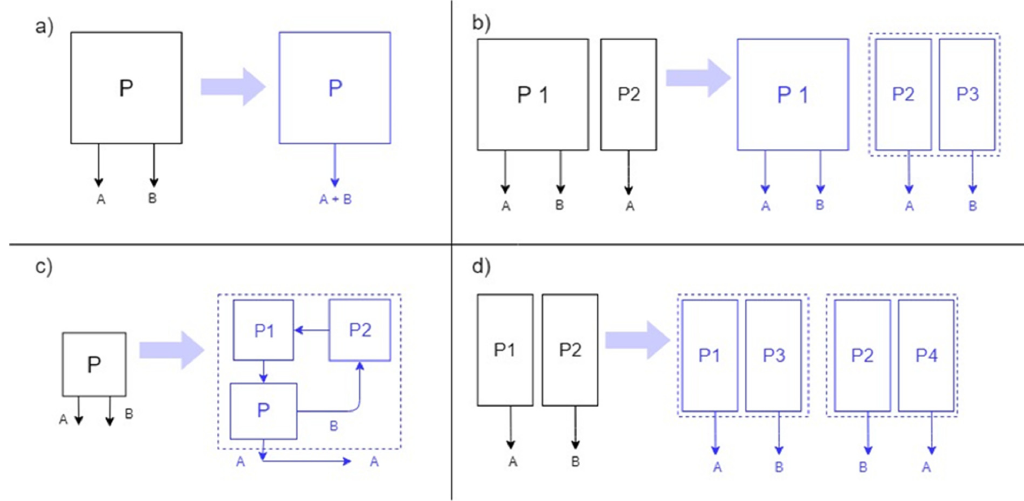
Figure A1. Different ways to apply system expansion as enlargement-addition of functions. In black: multifunctional process before applying system expansion. In blue: process after the expansion of the boundaries/addition of functions. ( a ) Changing the FU to avoid allocation. ( b ) Adding extra processes (P3, delivering B) to a system (P2, delivering A) that is compared with another system (P1) delivering several functions (A and B). ( c ) Applying closed-loop recycling to a system (P) where one of the outputs (B) is used as a material input in the same product system (P2 represents the intermediate processing of B that allows its re-use). ( d ) Adding extra processes (P3 and P4) to compare systems that provide different functions and that at the beginning were not multifunctional.